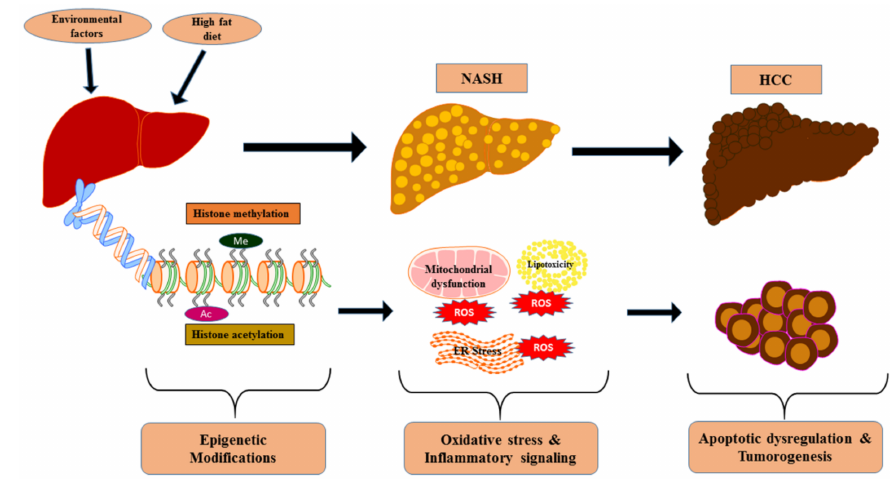
Figure 5. The coordinated epigenetics-mediated cellular events allied to the progression of nonalcoholic steatohepatitis (NASH) and associated